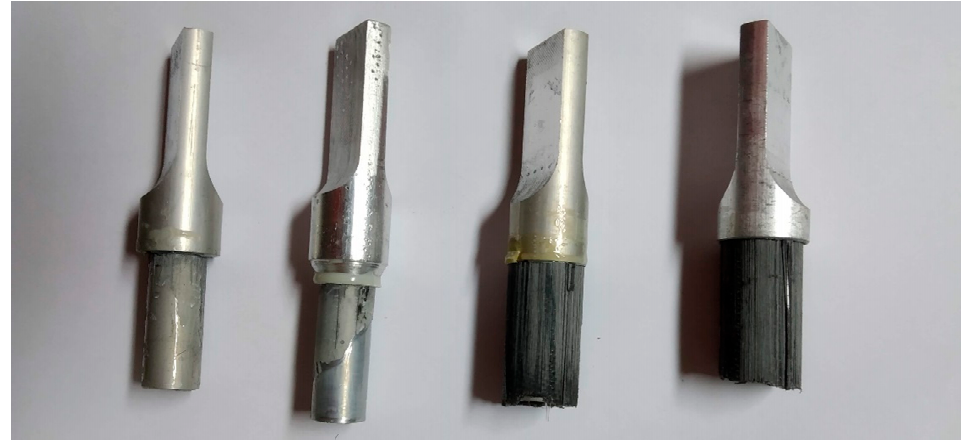
Figure 8. Failure modes of the adhesive bond—for geometrical solution on 3425 (two on the left ) and beads solution (two on the right ).